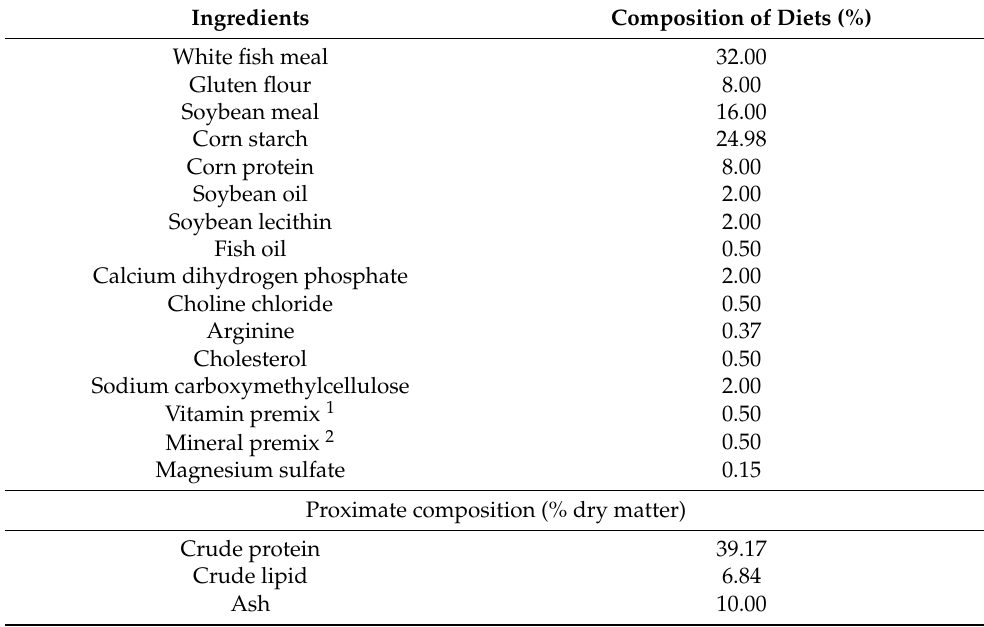
Table 1. Ingredients and chemical composition of the experimental diets